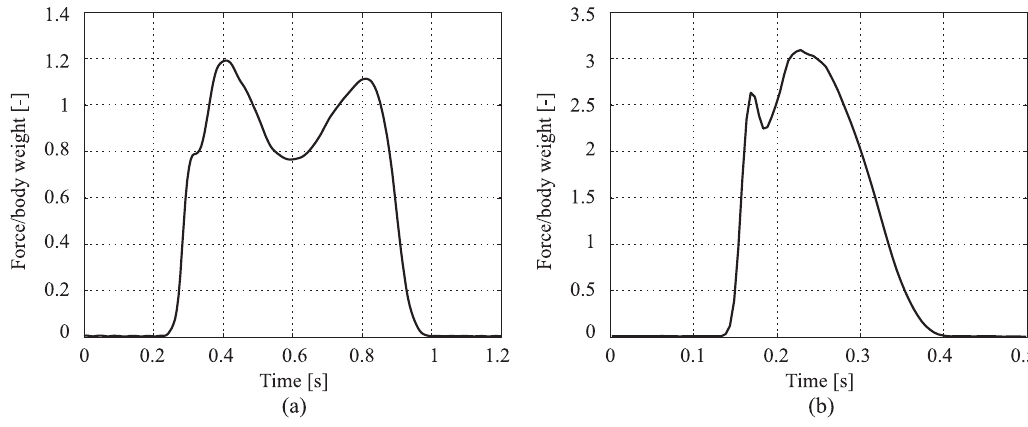
Fig. 5. Vertical GRF measured by a force plate due to a single person (a) walking and (b)